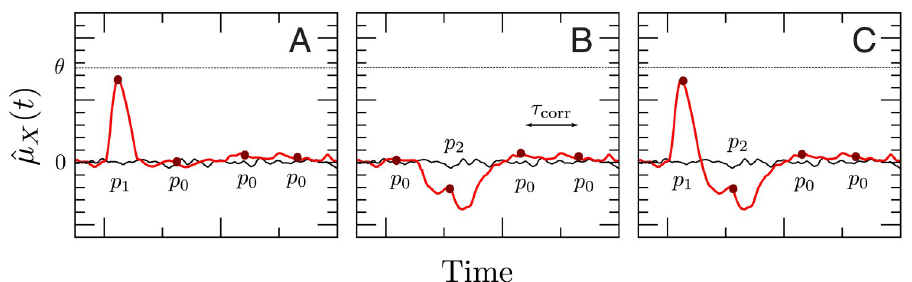
Fig 6. Illustration of simplified detection model used to interpret the simulation results. The continuous-time problem is approximated by a discretized process, obtained by “sampling” trajectories at times separated by the correlation time. In the spontaneous state, the probability that a time sample is not beyond the decision barrier θ is p 0 . A : The peak decreases the local probability of not reaching θ , i.e. p 1 < p 0 and the effect size is � Y increases the local probability of not reaching θ , i.e. p 2 > p 0 ; the effect size is here � Y are present and the changes in probability are small, the effect size is � Y